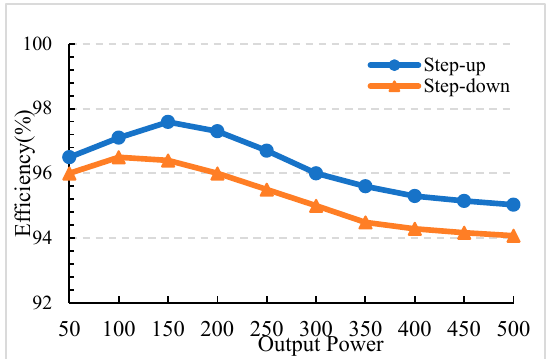
Figure 14. Efficiency of the proposed converter.